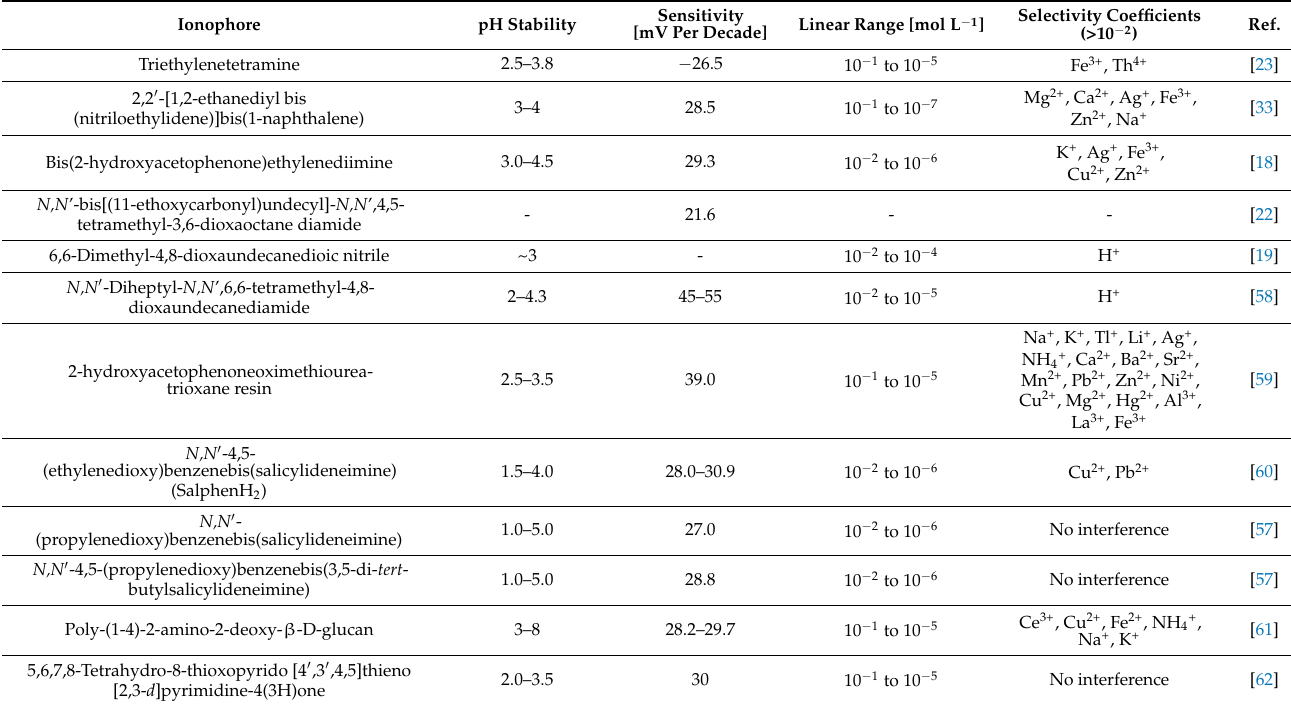
Table 4. An overview of uranium detection by PVC-based membrane electrodes with nitrogen- containing ligand-based